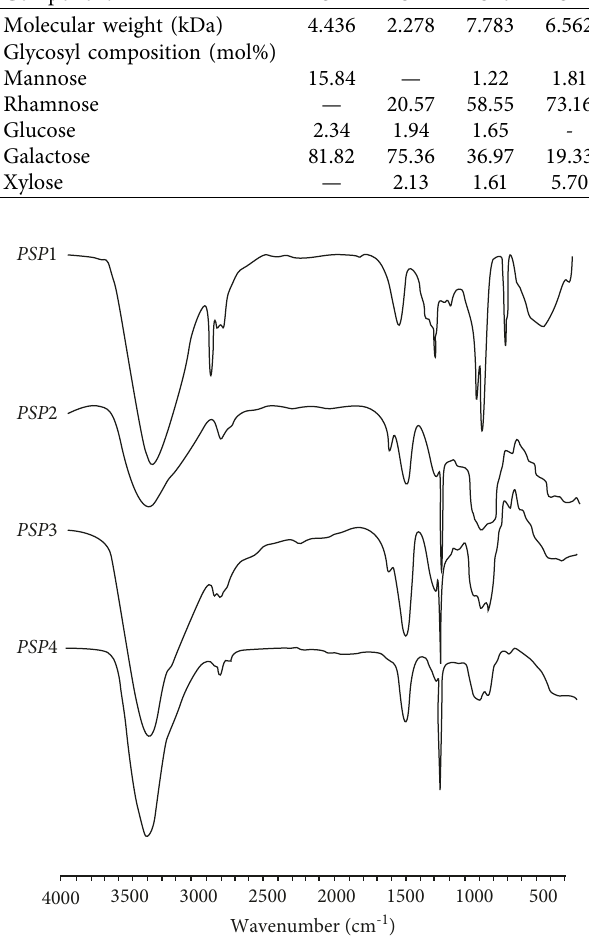
Figure 3: Effect of PSPs on RAW264.7 cell activity. Compared with control